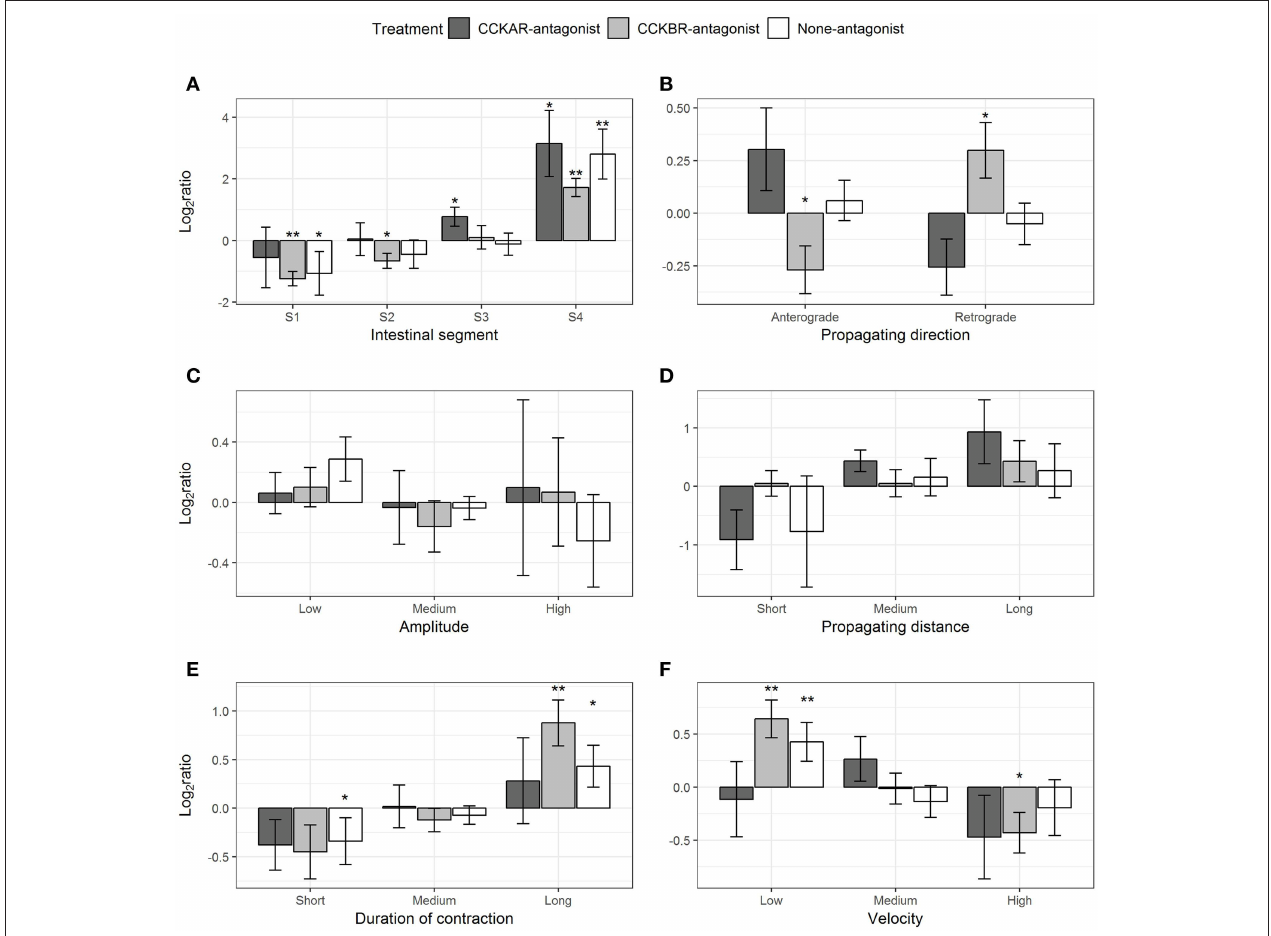
FIGURE 11 | Effect of CCK-8S with presence of CCK-receptor antagonists on slow propagating contractions. CCKAR-antagonist: intestines were pre-incubated with devazepide, CCKBR-antagonist: intestines were pre-incubated with L-365260, and none-antagonist: intestines were pre-incubated with DMSO as a control prior to exposing intestine to CCK-8S. The six plots show log 2 of ratios of contraction parameters recorded after to before exposing intestine to CCK-8S: (A) for frequency of slow propagating contractions measured in four intestinal segments (S1, S2, S3, and S4); (B) for proportion of slow propagating contractions which propagated with an anterograde or retrograde direction; (C) for proportion of slow propagating contractions which had a low, medium or high amplitude; (D) for proportion of slow propagating contractions which propagated for a short, medium, or long distance; (E) for proportions of ripples which prolonged for a short, medium, or long duration; (F) for proportion of slow propagating contractions which propagated at a low, medium or high velocity. Bars are presented with mean ± SEM ( n = 4 for CCKAR-antagonist, n = 5 for each CCKBR-antagonist/none-antagonist). Asterisk (*) denotes the statistically significant differences of ratio values compared with 0 (one sample t -test, *for 0.05 ≤ p < 0.1 and ** for p <